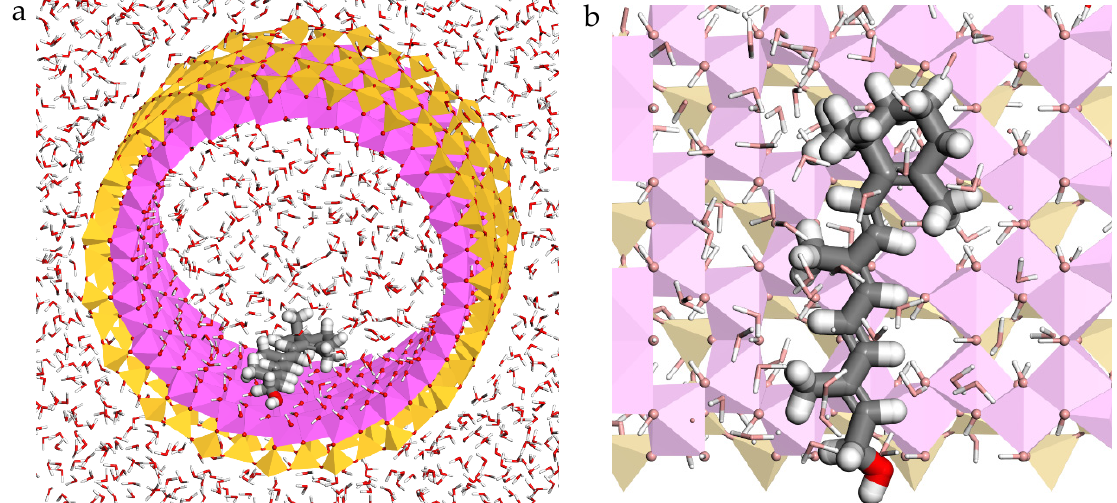
Figure 2. Optimized adsorption complex of the retinol adsorbed on the internal surface of halloysite nanotube with waters, views from (001) ( a ) and (100) ( b ) planes. The silicon, aluminium, hydrogen, carbon, and oxygen atoms are presented in yellow, pink, white, grey, and red respectively.